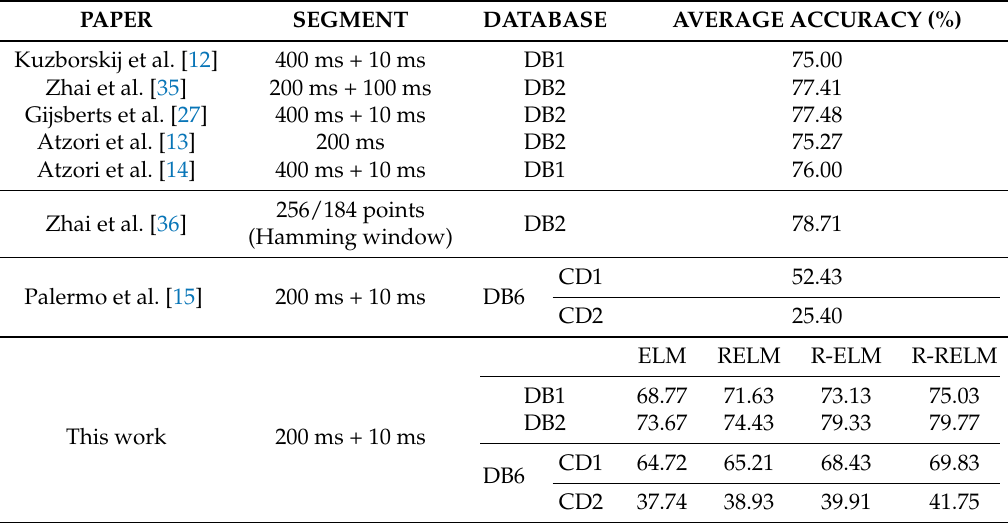
Table 3. Results and comparison with related papers in the area considering the three different NINAPro databases. CD,